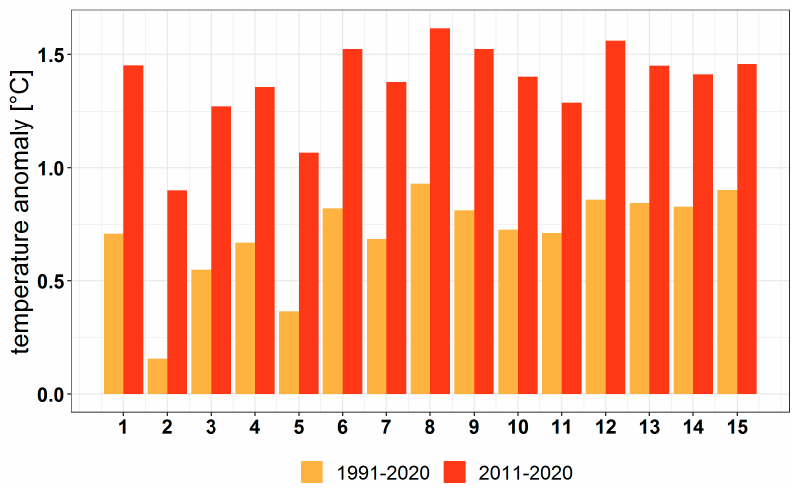
Figure 13. The differences in MT VS over the last 30 years compared to 1951–1960 decade for the main forest types.